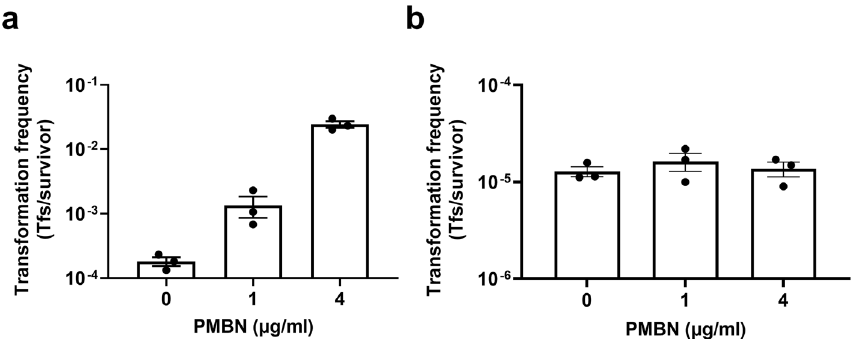
Figure 2. PMBN-mediated effects on electrotransformation frequency of S. typhimurium and P. mirabilis . Electrotransformation frequency of S. Typhimurium SL1344 ( a ), and uropathogenic P. mirabilis strain PM54 ( b ) grown in different concentrations of PMBN. In all experiments, the starting competent cell density was the same between groups. Data from three independent experiments are shown with bars denoting the group mean and error bars the standard error of the mean (mean ± SEM). Tfs transformants.